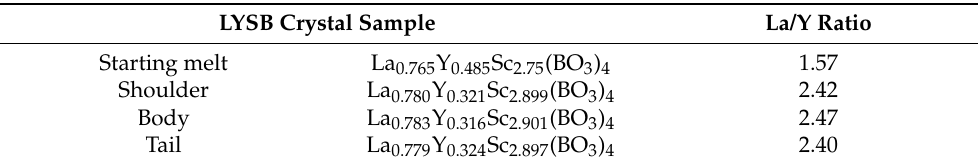
Table 1. Chemical compositions of samples cut from different regions of the LYSB crystal. (Reprinted with permission from ref. [13], copyright 2019 American Chemical